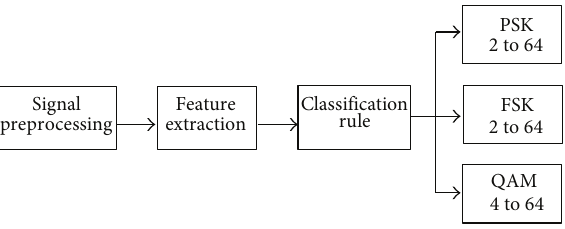
Figure 1: System model for modulation classification.